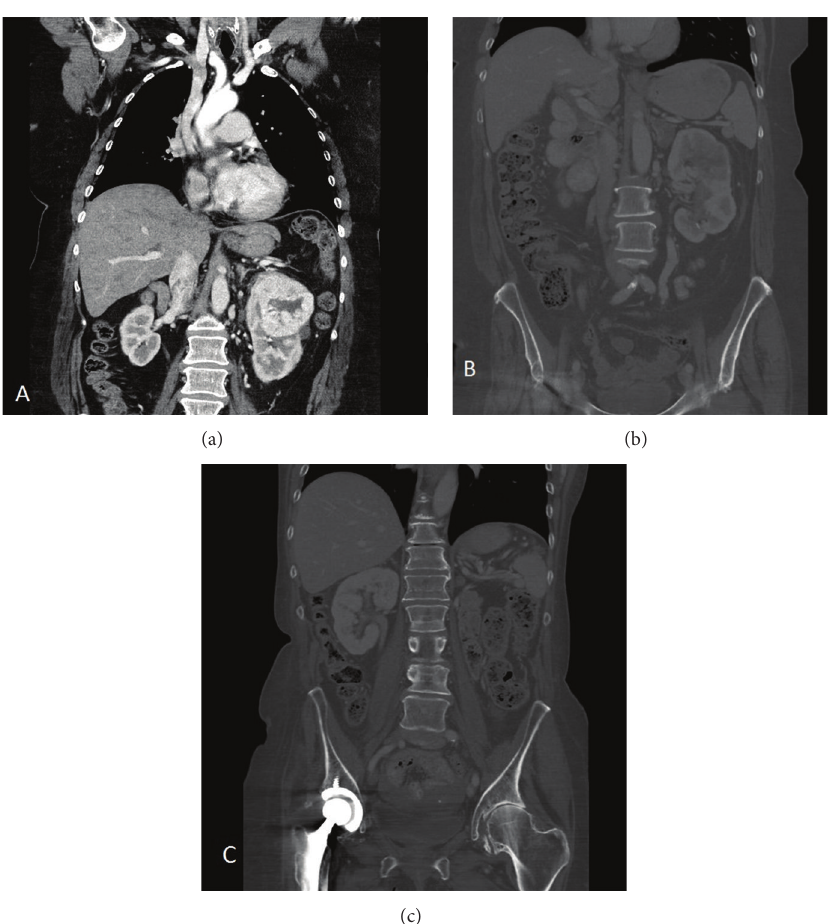
Figure 3: (a) Enhanced CT finding on diagnosis demonstrating the large tumour arising from the upper pole of the left kidney. (b) CT abdomen and pelvis after TKI administration: note the shrinking of the primary tumour. (c) Latest CT abdomen, as part of postoperative